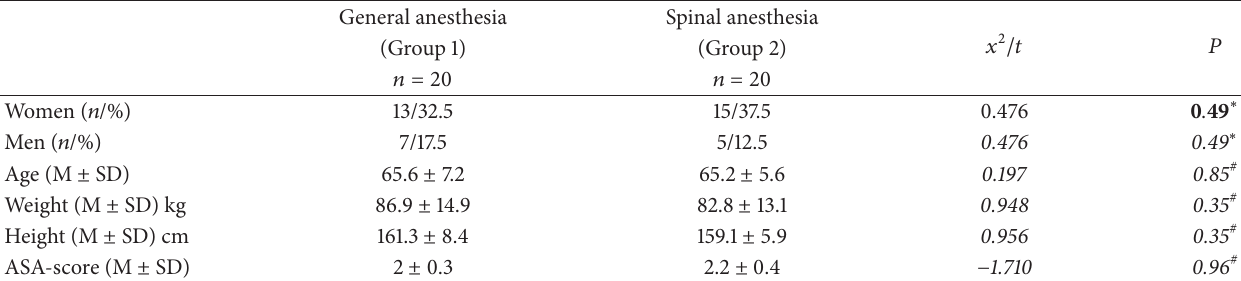
Table 1: Demographical parameters of all